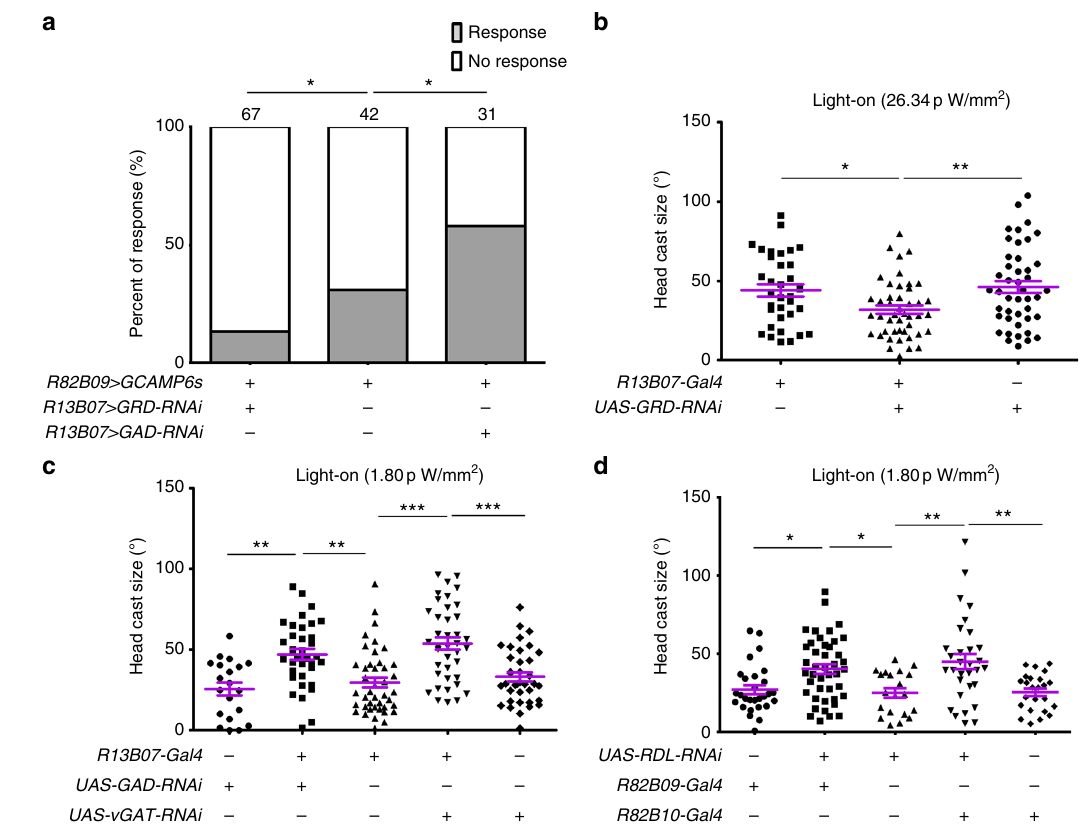
Fig. 4 Larval reorientation at light-on is facilitated by disinhibition of CLPN R82B09 s. a Knocking down GRD and GAD expression in LRIN R13B07 s, respectively, reduces and increases the probability for CLPN R82B09 s to respond to light in calcium imaging. One second 470 nm light stimulation at intensity of 1.058 μ W/mm 2 was used. Numbers above columns indicate sample sizes. Genotypes of larvae used are R82B09-LexA/UAS-GRD-RNAi;LexAop-GCAMP6s/ R13B07-Gal4 , R82B09-LexA/ + ;LexAop-GCAMP6s/ + and R82B09-LexA/UAS-GAD-RNAi;LexAop-GCAMP6s/R13B07-Gal4 , respectively. b – d Size of larval head cast at light-on in the light spot assay is reduced by downregulation of GRD in LRIN R13B07 s ( b ), but is enhanced by down regulation of GAD/vGAT in LRIN R13B07 s ( c) or RDL in CLPN R82B09 s ( d ). Light intensity in spot measured at 470 nm was 26.34 pW/mm 2 for b , 1.80 pW/mm 2 for c – d . * P < 0.05, ** P < 0.01, *** P < 0.001, χ 2 -test with subgroup comparisons controlled by Benjamini-Hochberg method in a , one-way ANOVA with Tukey ’ s post hoc test in b – d . Error bars, SEMs. Source data of a – d are provided as a source data fi